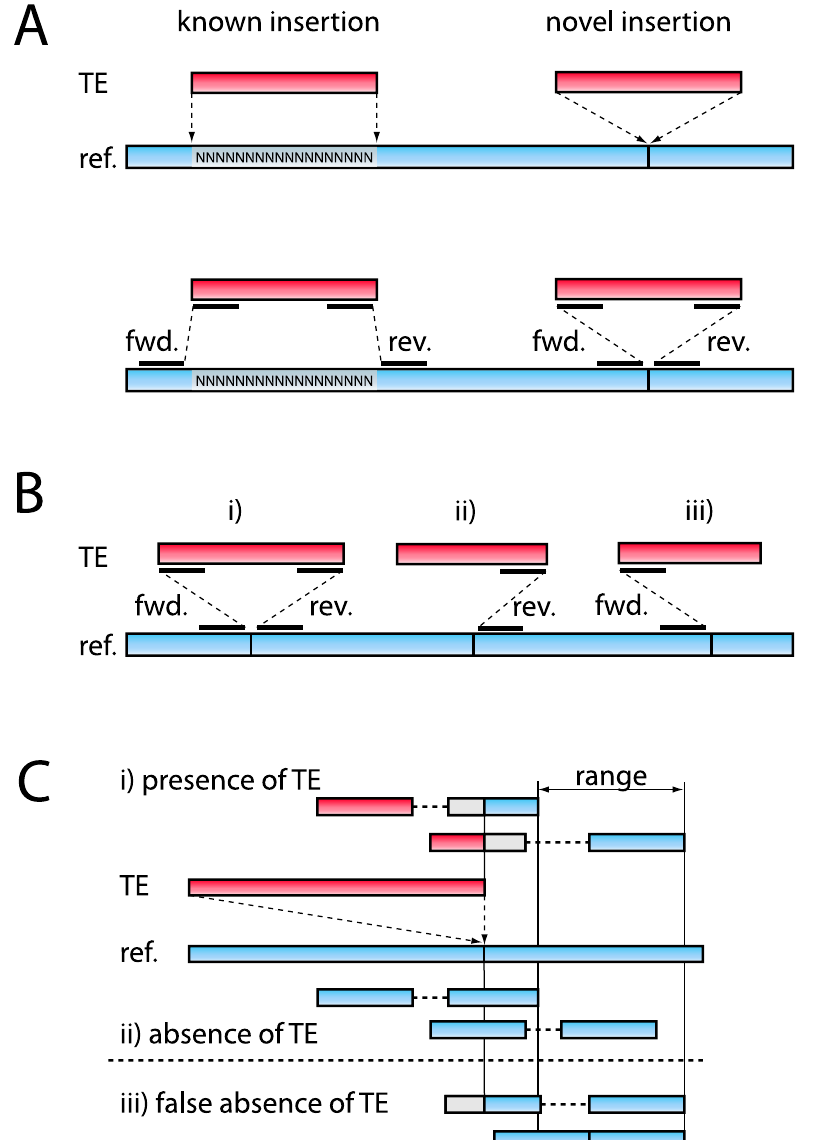
Figure 1. Outline of the method used to identify TE insertion polymorphism. (A) Top: Examples of a ‘‘known’’ insertion in the repeat masked reference genome, and of a ‘‘novel’’ insertion, not in the reference. Bottom: Paired ends mapped to known and novel insertions. (B) Three TE insertions identified by i) reads both 5 9 and 3 9 of the insertion site (forward and reverse insertions), ii) reads 3 9 of the insertion site (reverse insertion), iii) reads 5 9 of the insertion site (forward insertion). (C) Estimating the population frequency for a reverse insertion. First, the end positions of the reads confirming the presence of an insertion are recorded, and based on this information a range is defined. Subsequently, all PE fragments within this range that either confirm the absence or the presence of a TE insertion are tallied (see text). The reference genome and reads mapping to the reference genome are shown in blue. TE’s and reads mapping to TE’s are shown in red. Sequences not aligned by the Smith-Waterman algorithm are shown in